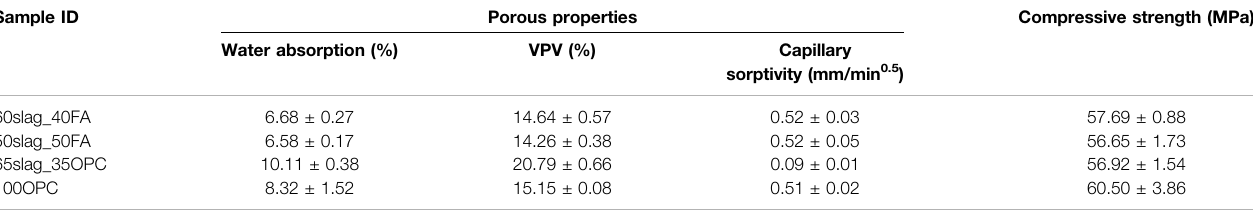
TABLE 3 | Porous properties and compressive strength of the four mortar mixes after 56 days of curing. Sample ID Porous